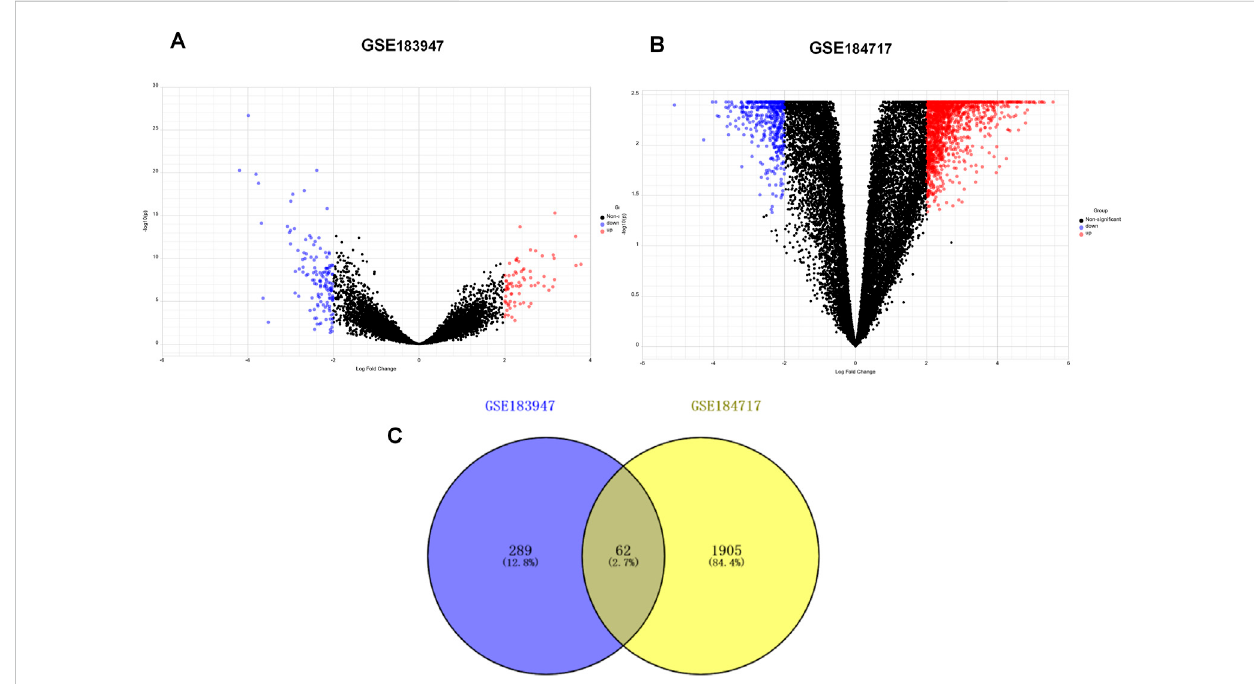
FIGURE 2 Identi fi cationofdifferentiallyexpressedgenes(DEGs). (A) Volcano plotof DEGsbetweenprimarytumor andpairednormaltumor inGSE183947. (B) Volcano plot of DEGs between metastasis tumor and paired normal tumor in GSE184717. (C) Venn diagram showing the intersection of the DEGs in GSE 183947 and GSE